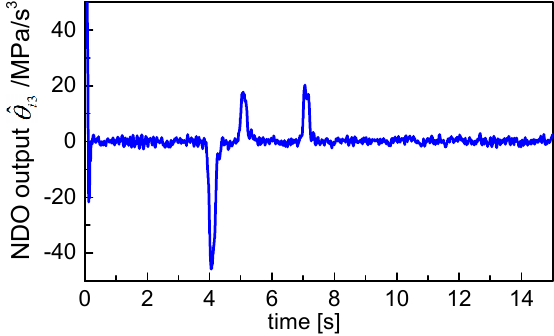
θ as a function of time. 2 i